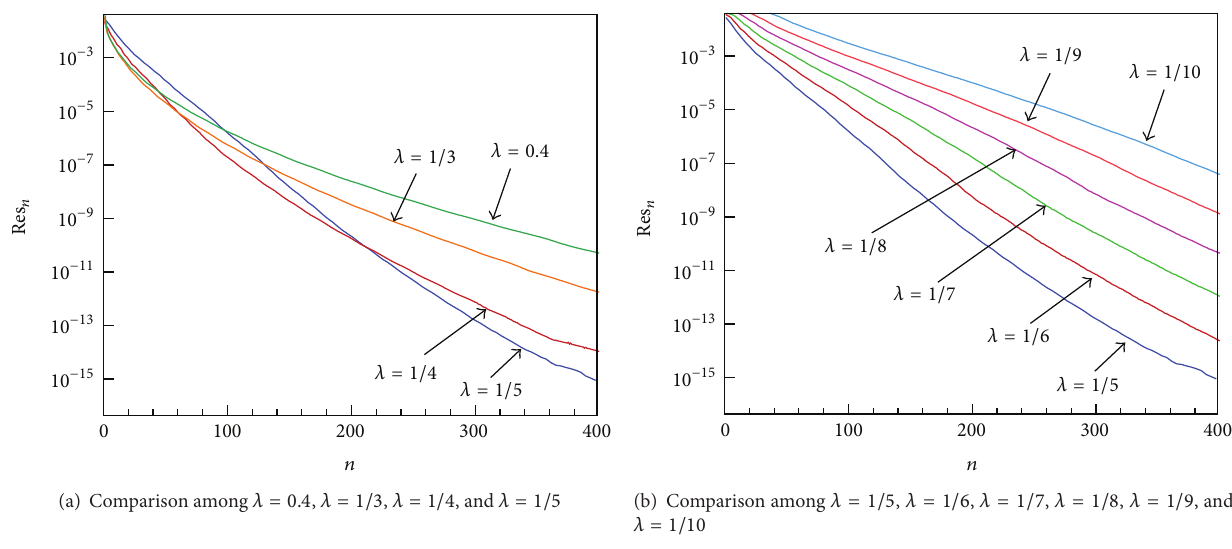
(a) Comparison among 𝜆 = 0.4 , 𝜆 = 1/3 , 𝜆 = 1/4 , and 𝜆 = 1/5 (b) Comparison among 𝜆 = 1/5 , 𝜆 = 1/6 , 𝜆 = 1/7 , 𝜆 = 1/8 , 𝜆 = 1/9 , and 𝜆 = 1/10 Figure 5: The influence of 𝜆 value on the square residual error Res 𝑛 .